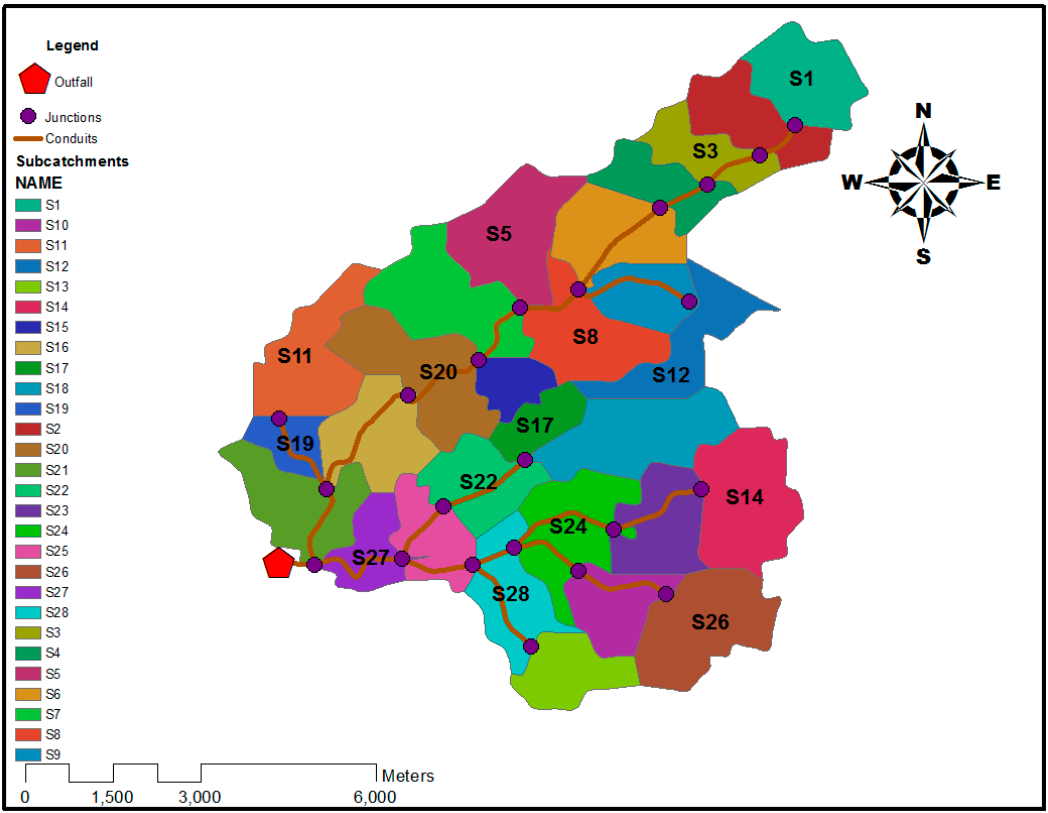
Figure 3. Catchment discretization for modelling.